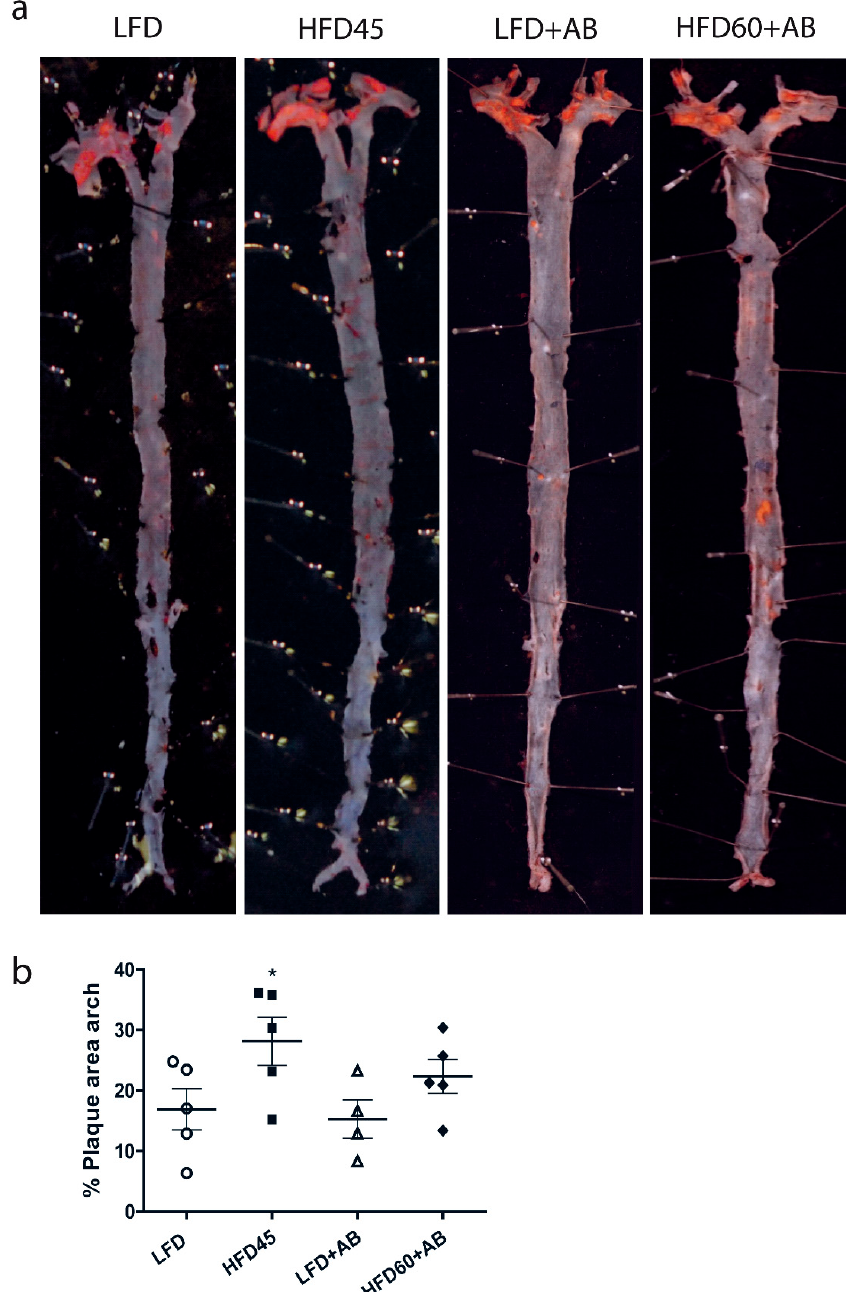
Figure 6. Analysis of atherosclerotic plaques in LDLR -/- mice after 12 weeks of nutritional interven- tion with AB extract. ( a ) Representative images of lesions in en face aortas stained with Oil Red O. ( b ) Aortic arch lesions in the different groups. All data are shown as the means ± SD ( n = 5). * p ≤ 0.05 vs. the LFD control and LFD+AB groups.